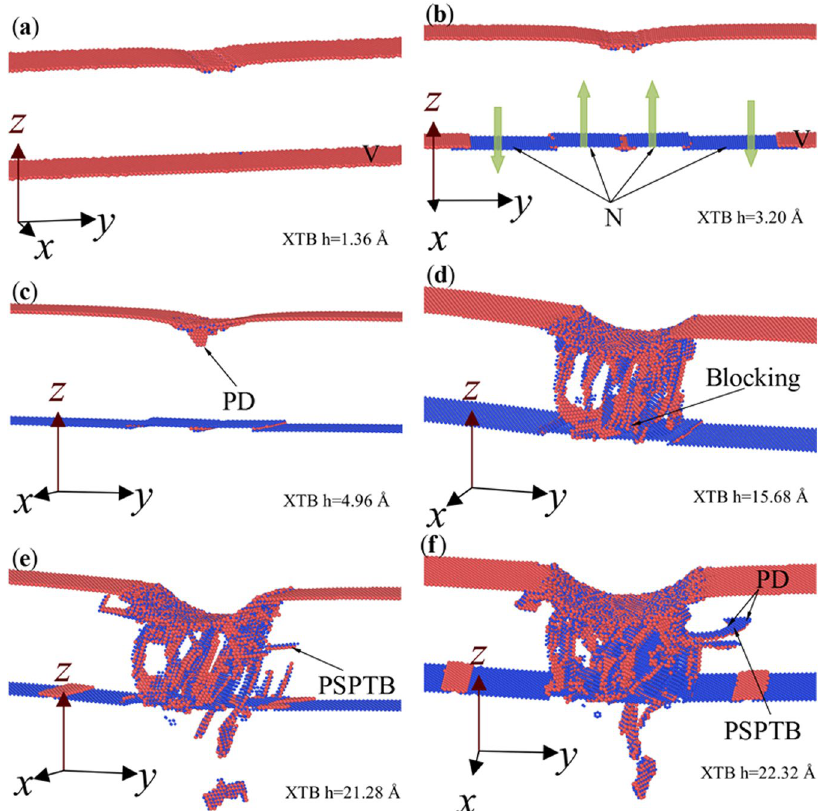
Figure 6. Microstructures evolution in XTB colored with atomic type at different depths. ( a ) h = 1.36 Å, ( b ) h = 3.20 Å, ( c ) h = 4.96 Å, ( d ) h = 15.68 Å, ( e ) h = 21.28 Å and h = 22.32 Å. Atoms with CSP < 0.5 and indenter atoms have been removed.